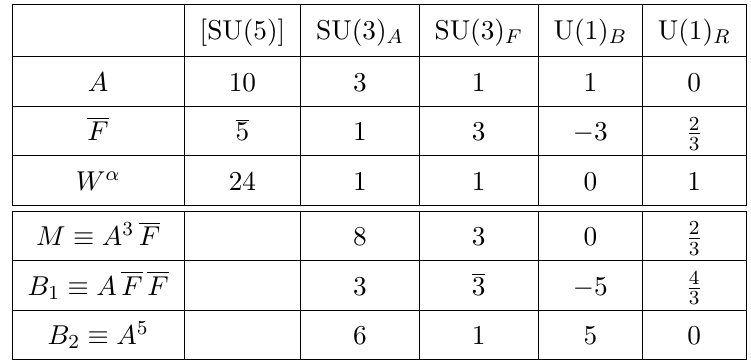
Table 4 . The anomaly-matched supersymmetric UV and IR theories. W α is the gauge superfield whose lowest component is a fermion (gaugino). The R charge is that of the lowest component of the given